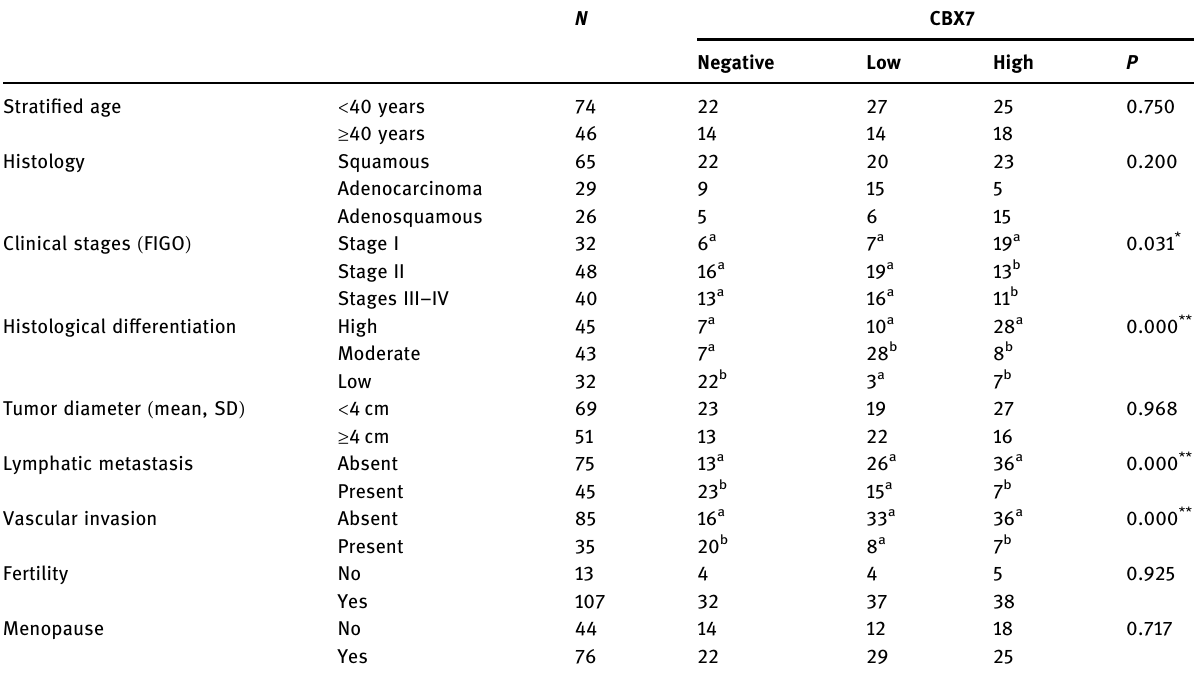
Table 1: Expression of CBX7 in CC tissue and its association with clinicopathological